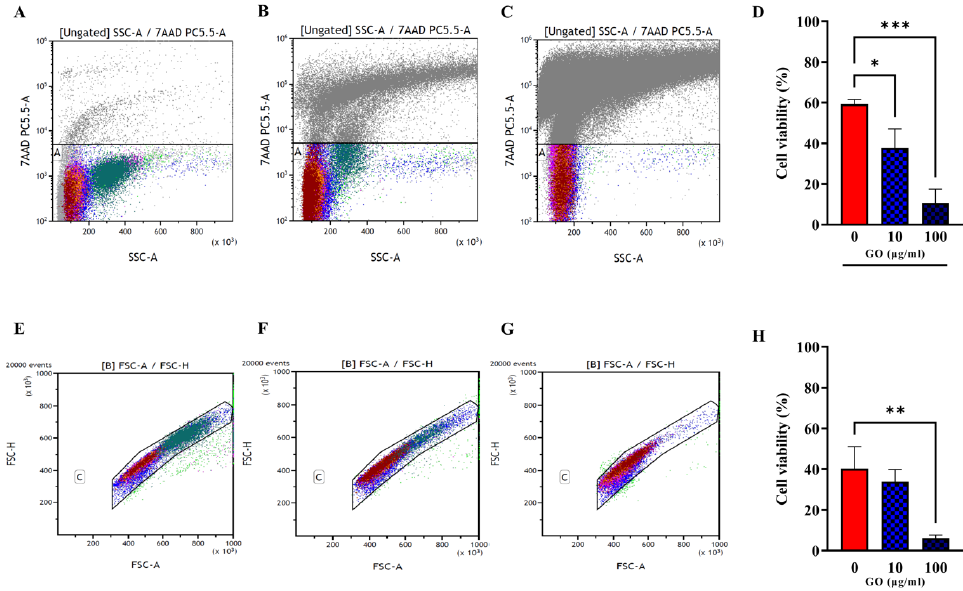
Figure 3. Viability assessment of hPBMCs after GO treatment. Total cell viability evaluated through 7AAD PC5.5-A versus Side Scatter (SSC-A) gating was evaluated among not treated hPBMCs ( A ) and hPBMCs following incubation for 1 h, with GO at the final concentrations of 10 µ g/mL ( B ) and 100 µ g/mL ( C ). ( A – C ) Charts were quantitatively analysed and represented as histograms showing average ± standard deviation. ( D ) Cells treated with GO 100 µ g/mL show a strong reduction in viability compared to untreated ( p value = 0.0002), while cells treated with GO 10 µ g/mL undergo a slighter reduction in viability. Cell viability was analysed purging samples from doublets and debris (( E ); not treated hPBMCs; ( F , G ) cells incubated with GO at 10 µ g/mL and 100 µ g/mL) by using Forward scatter Height (FSC-H) versus Forward Scatter Area (FSC-A) gating. ( H ) Quantitative representation of ( E – G ) panels. Cell viability decrease is confirmed for GO 100 µ g/mL ( p value = 0.0089). (* p value < 0.05; ** p value < 0.01; *** p value < 0.001).